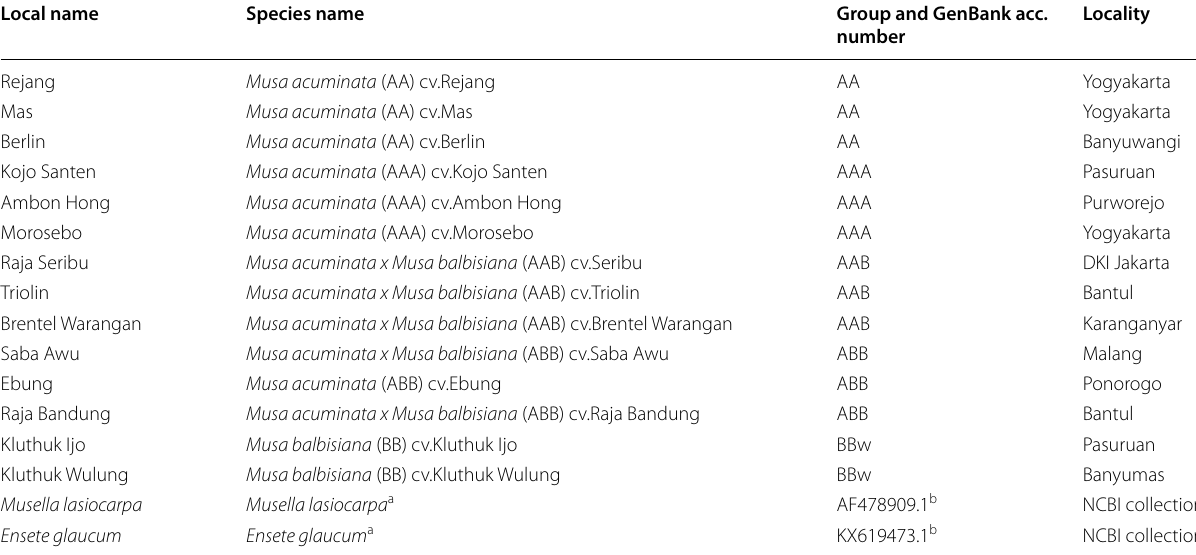
Genome identity based on morphological character a Out-group from NCBI b GenBank acc. number